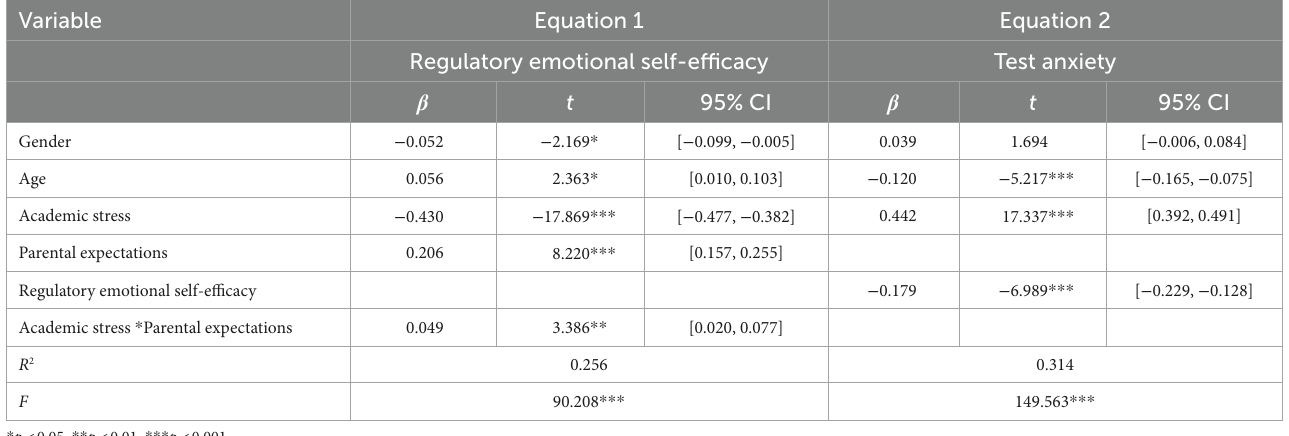
TABLE 3 The moderated mediation effect test.